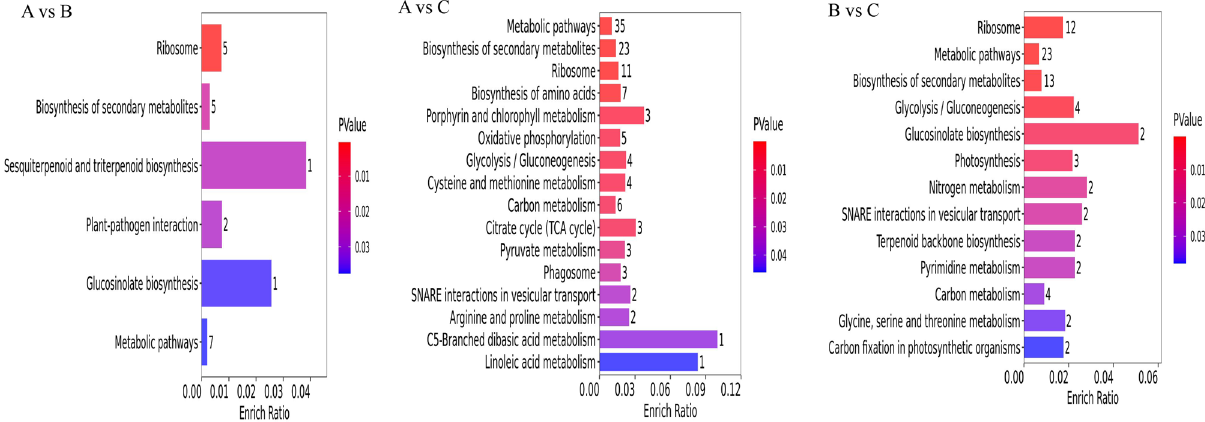
Figure 6. Bar diagrams of the differential proteins’ KEGG enrichment